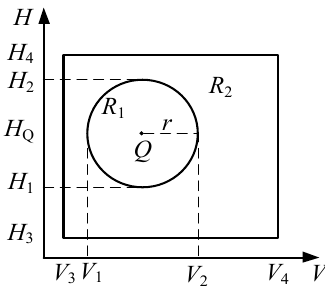
Fig. 1. Query range and Cloaked